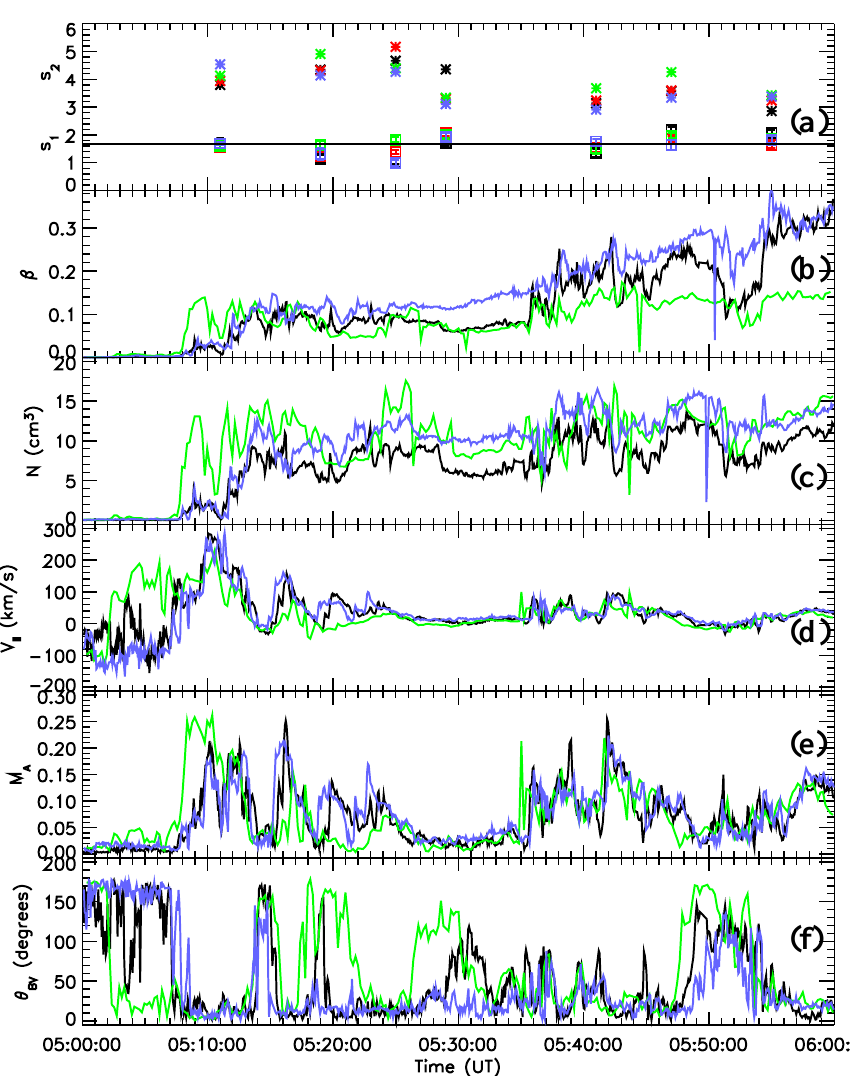
Fig. 1. Power spectral slopes and plasma parameters between 05:00–06:00 UT. Panel (a) shows inertial ( s 1 ) and dissipation ( s 2 ) range slopes. The solid line is at 5/3. Panels (b)–(f) show the ion plasma beta ( β ), the plasma density ( N ), parallel plasma velocity ( V k ), Alfv´en Mach number ( M A ) and the angle between plasma flow and the magnetic field ( θ BV ). Black is data from spacecraft 1 (hereafter sc1), red from sc2, green from sc3 and blue from sc4. The spacecraft separation is 600km and Cluster altitude in the cusp is ∼ Z GSM = 8 R E